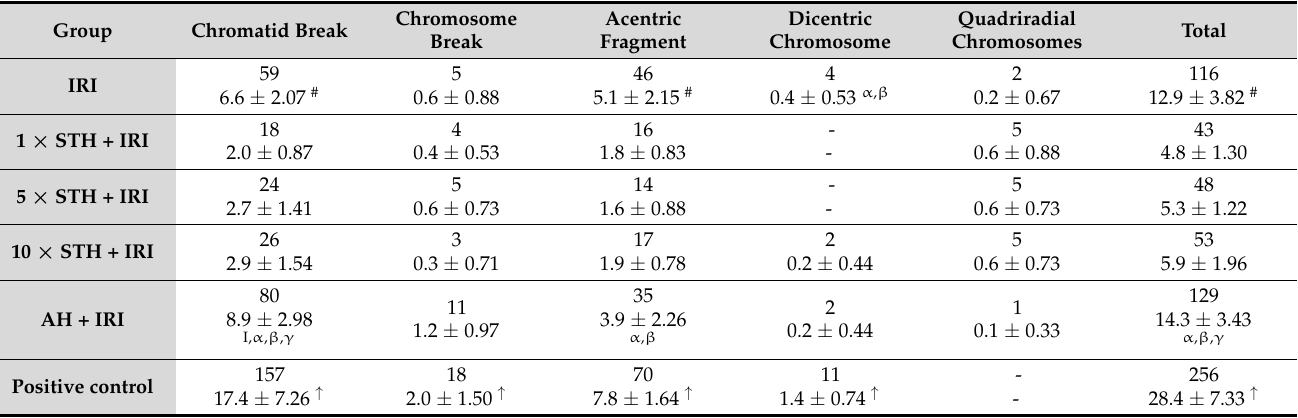
Table 5. Results of CA assay after treatment with different combinations of cytotoxic drug irinotecan (IRI) with strawberry tree honey (STH) and artificial honey (AH). Single-IRI-treated cells and positive control (bleomycin — 15 mg/L) cells were studied in